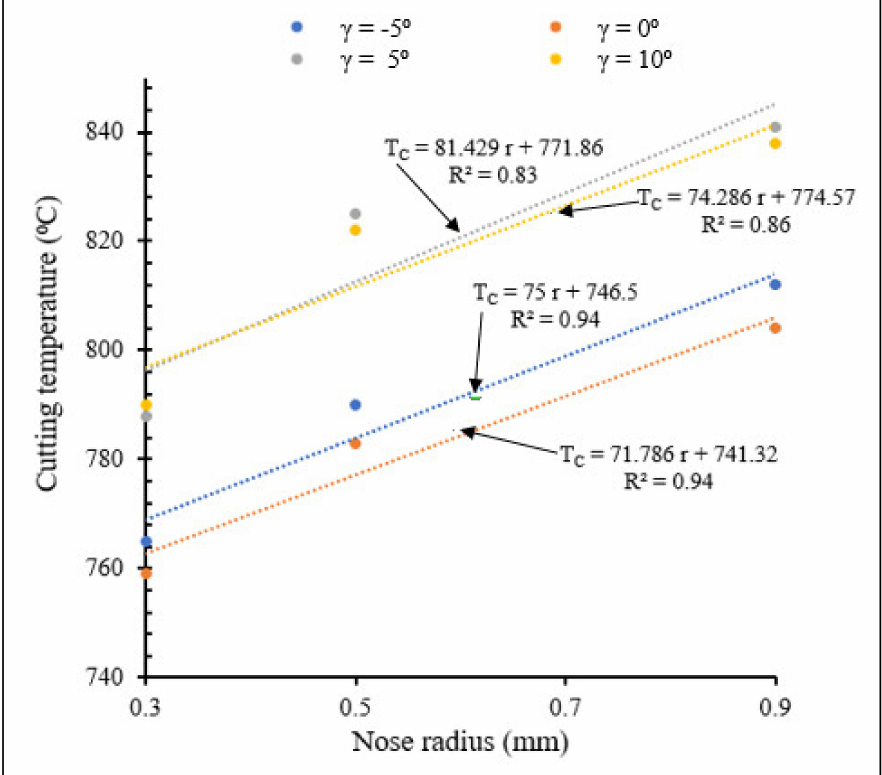
Figure 21. Variation of cutting temperature with large tool nose radius for different rake angles at V = 400 m/min, f = 0.1 mm/rev.